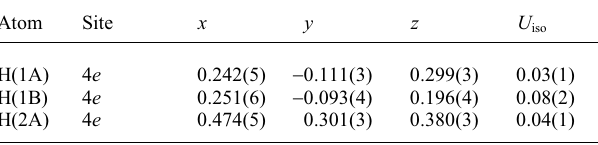
Table 2. Atomic coordinates and displacement parameters (in Å 2 )